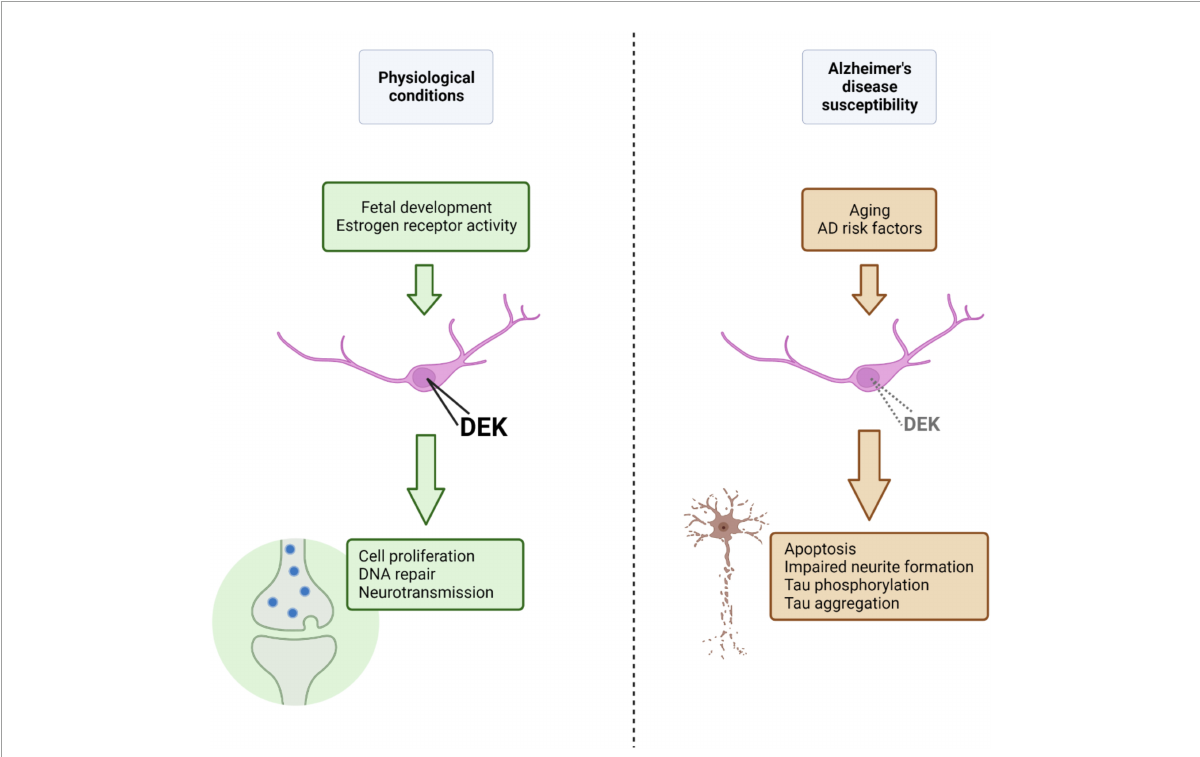
FIGURE1 Under physiological conditions, nuclear DEK expression, promoted and maintained by factors such as estrogen receptor activity or age (i.e., fetal development), is important for a variety of processes in the central nervous system (represented in green). Aging and other AD risk factors, in theory, could lead to decreased nuclear DEK expression (although the effect of specific AD risk factors on DEK expression is largely unknown), resulting in aberrant cellular processes, declined neuronal health, and phenotypes of AD (represented in brown). Figure created using